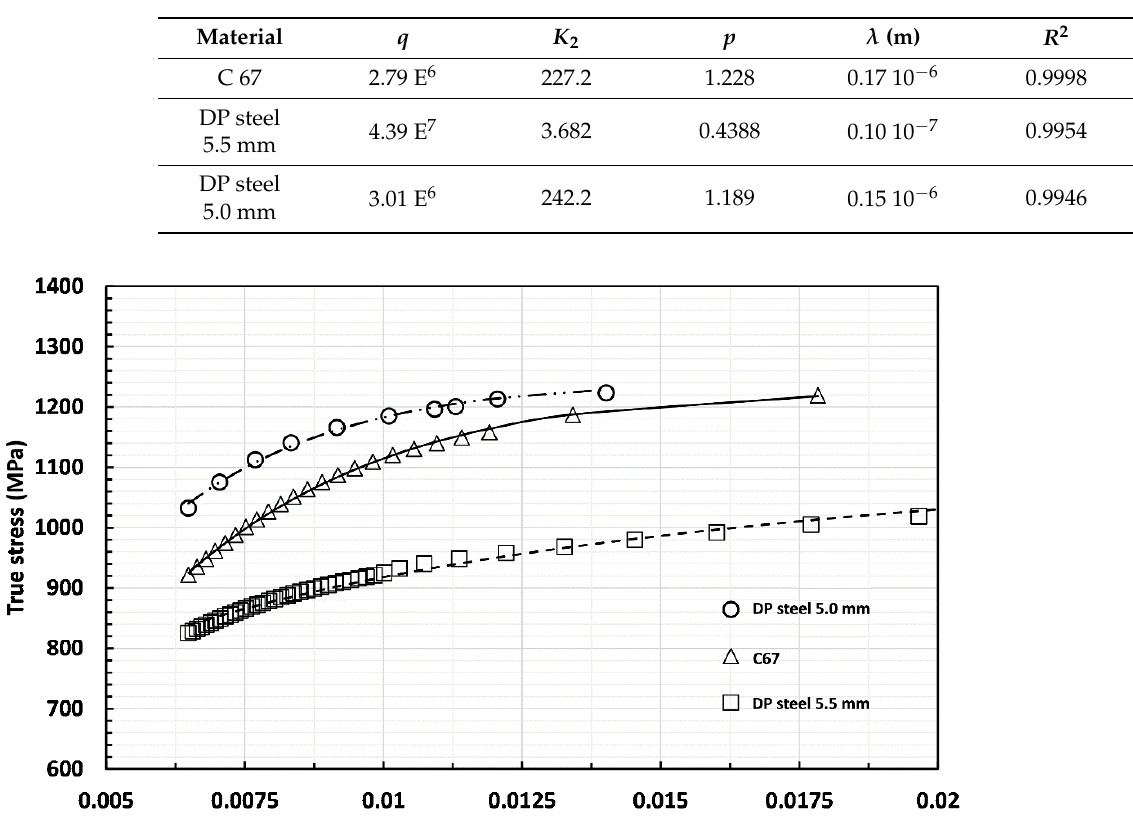
Table 3. Fitting parameters of Equation (4), calculated dislocations mean free path, and accuracy of the interpolation expressed via R 2.